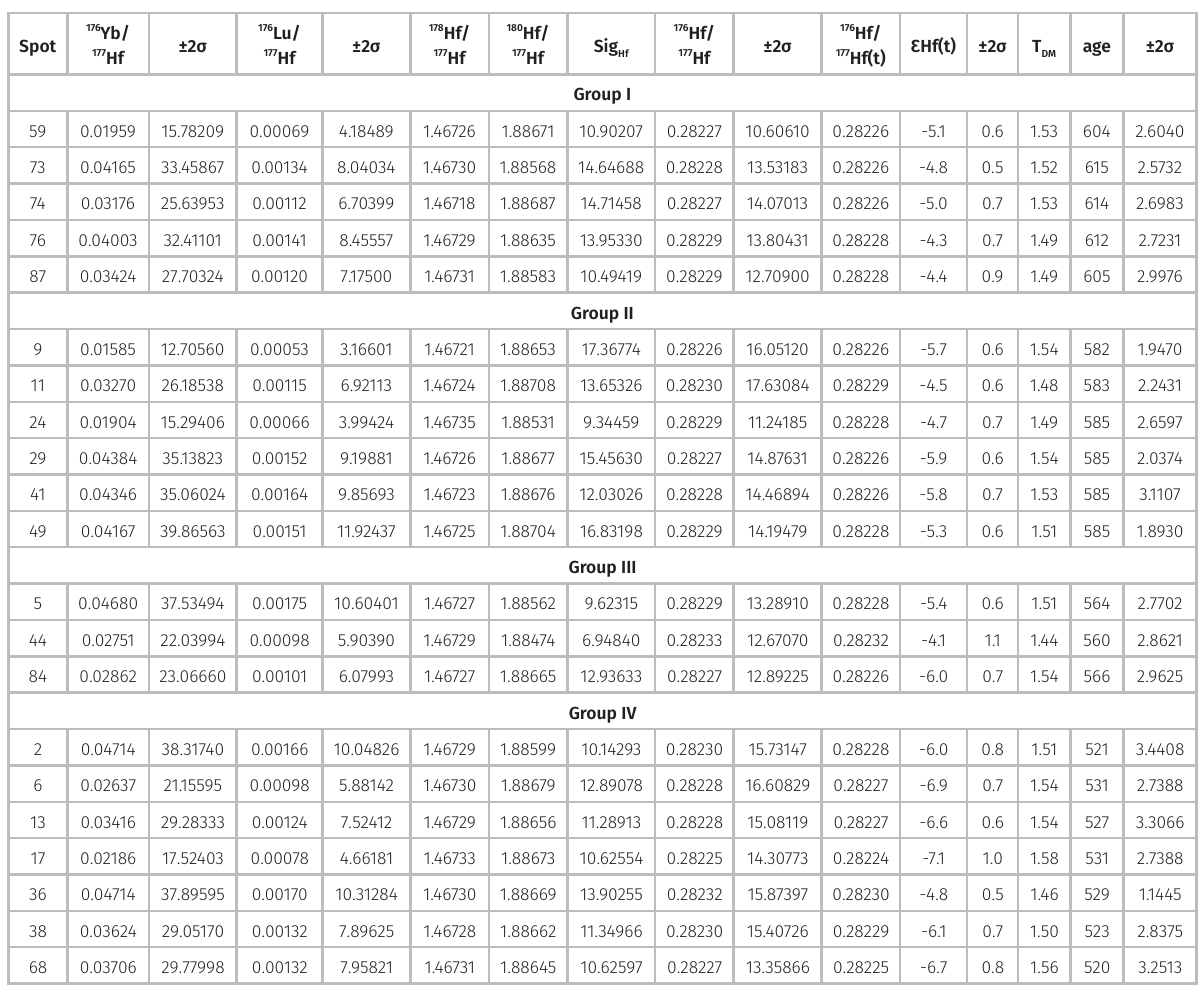
Table IX. Hf isotopes results determined by